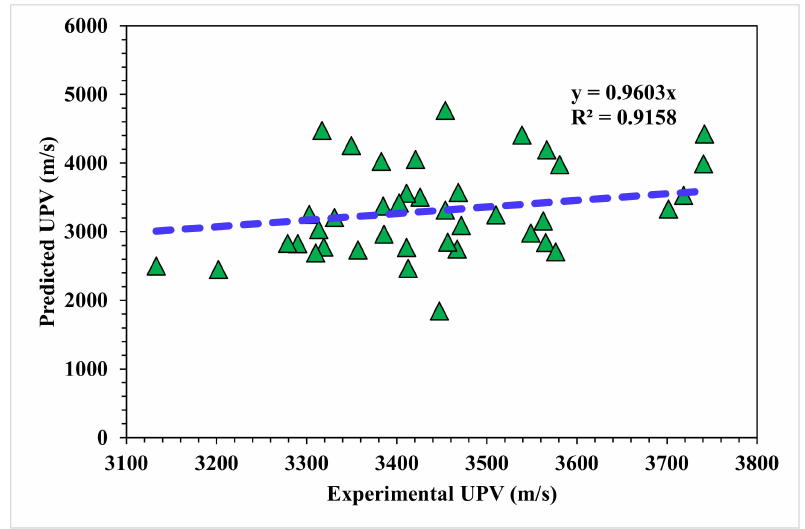
Figure 10. AdaBoost model experimental and predicted results.